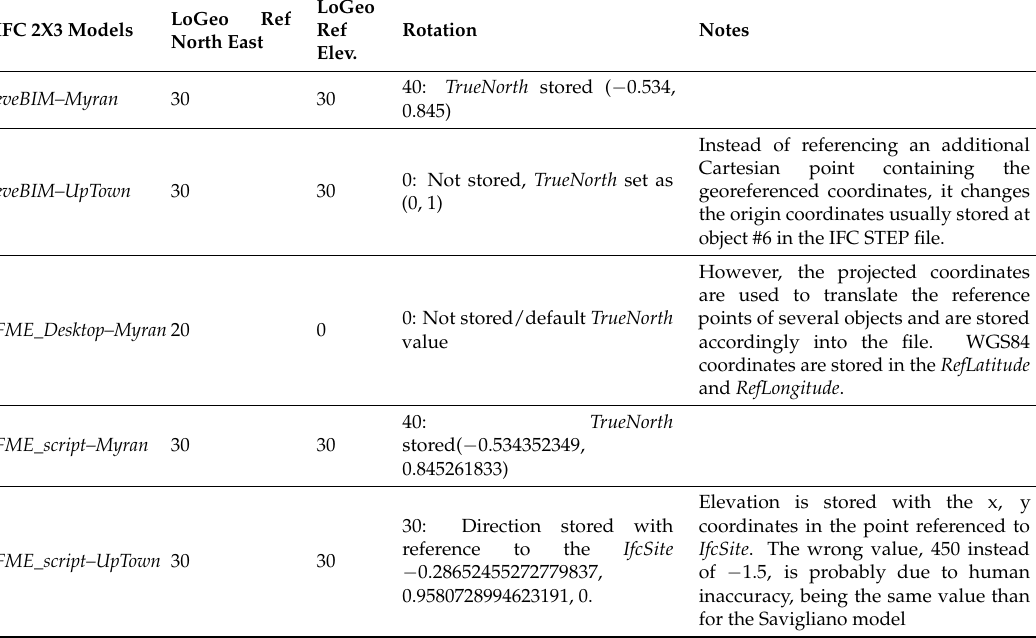
Table 6. Results of the applied georeferencing procedures to the models, exported in IFC v.2x3 by participants. IFC 2X3